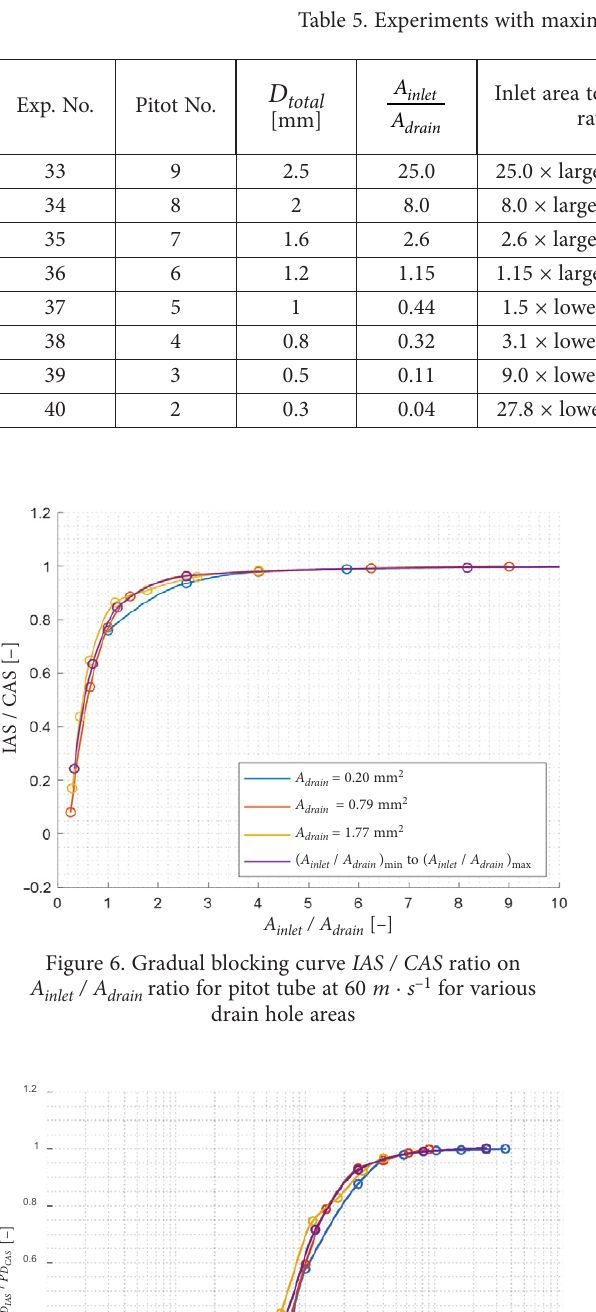
Figure 7. Gradual blocking curve / A inlet / A drain ratio for pitot tube at 60 m · s –1 for